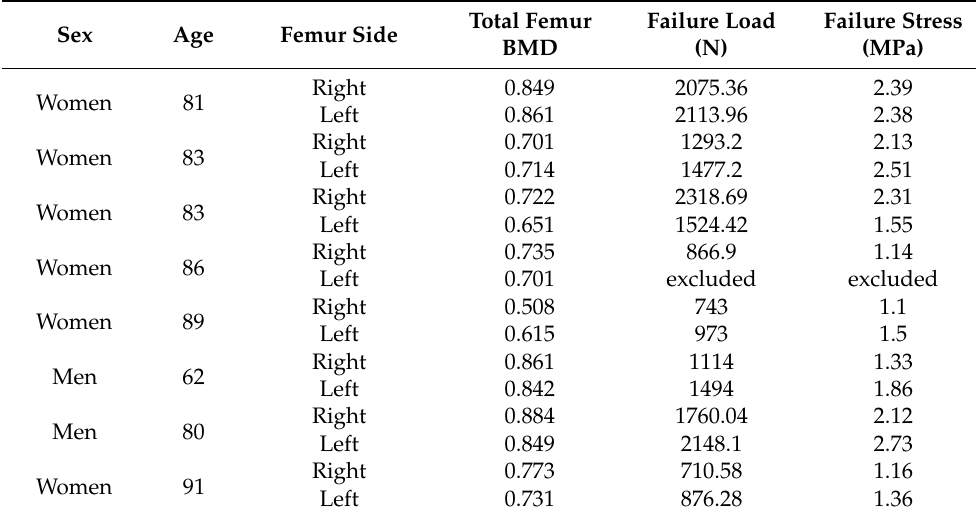
Table 1. Information on the subjects and femurs. Sex, age, total femur bone mineral density (g/cm 2 ), failure load of the femur (N) and failure stress (MPa).